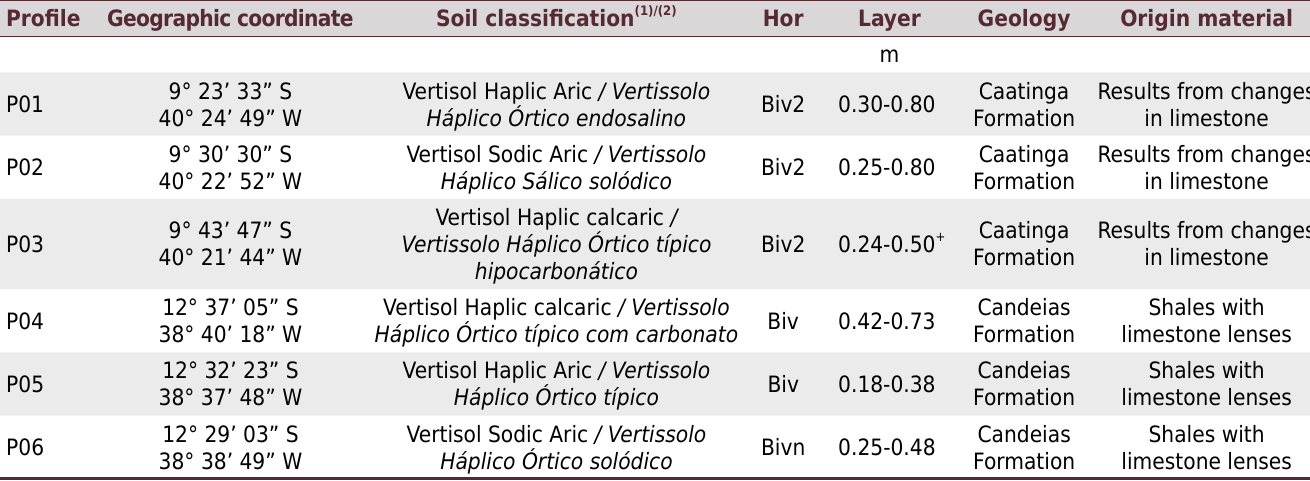
Table 1. Profiles location, classification of, and data about the analyzed horizons and physical environment Profile Geographic